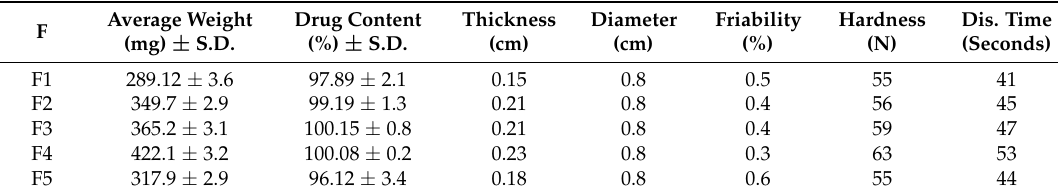
Table 3. Post-compression characterization of EPL-NE liquisolid